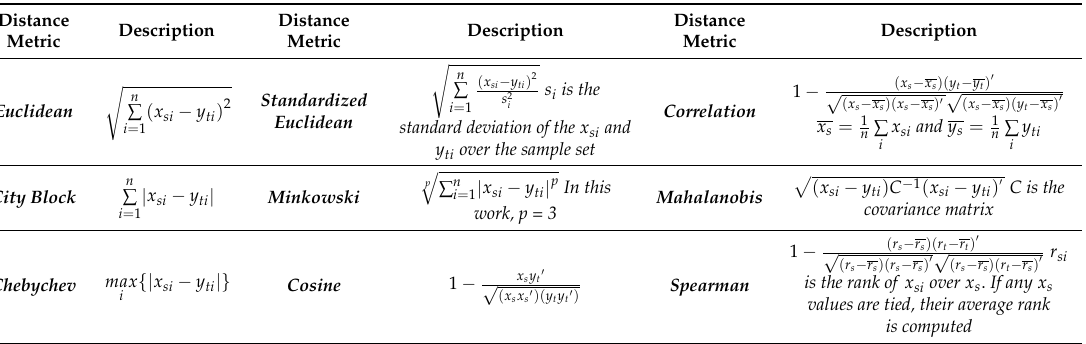
Table A3. The distance metrics in